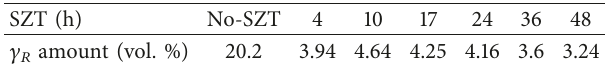
Table 1: Amount of retained austenite (vol. %) in the SZTsamples for various soaking times (h).